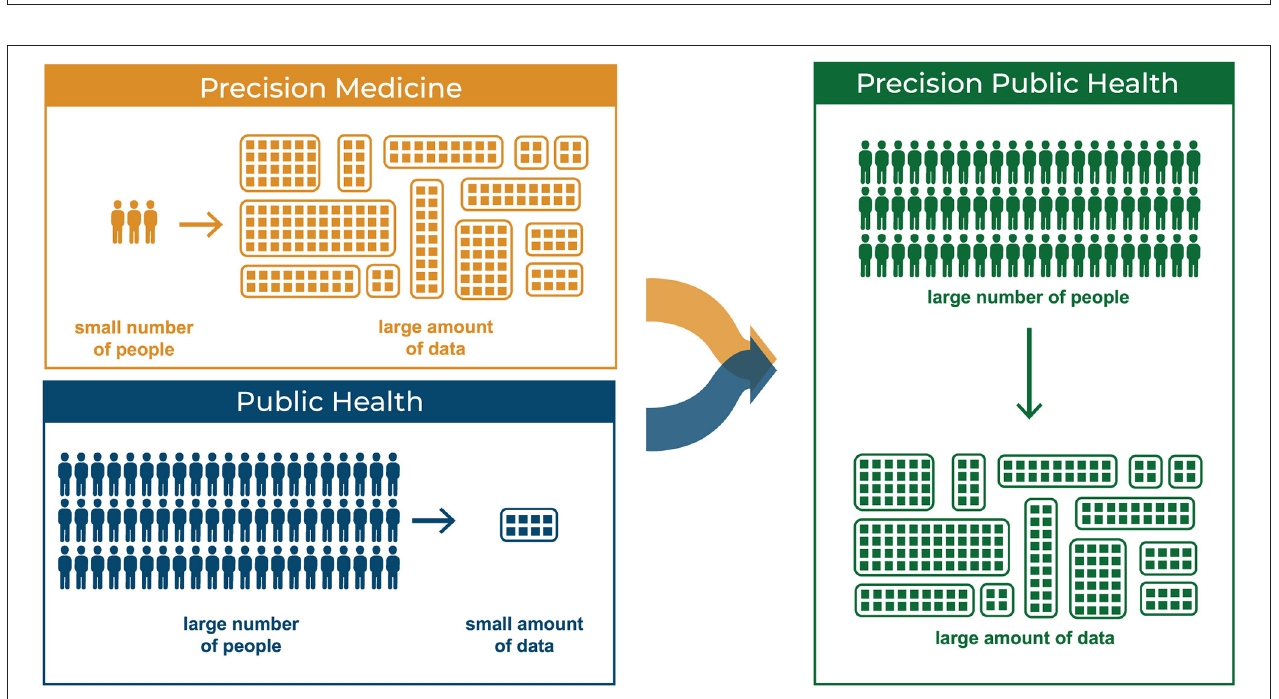
FIGURE 2 | Precision Medicine: few people providing a large number of types of data. Public Health: large number of people providing limited types of data.